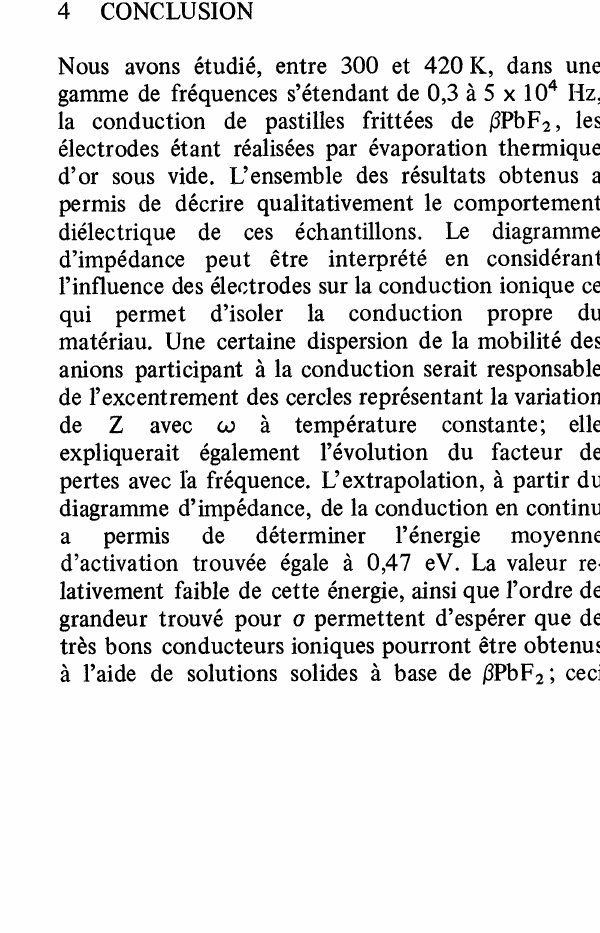
FIGURE 4 Mesure de l’nergie d’activation: a) de la conductivit a obtenue par extrapolation du diagramme d’impdance, b) de la frquence FR correspondant au maximum de tgS. c)de la frquence F pour laquelle la pattie imaginaire de l’impdance est